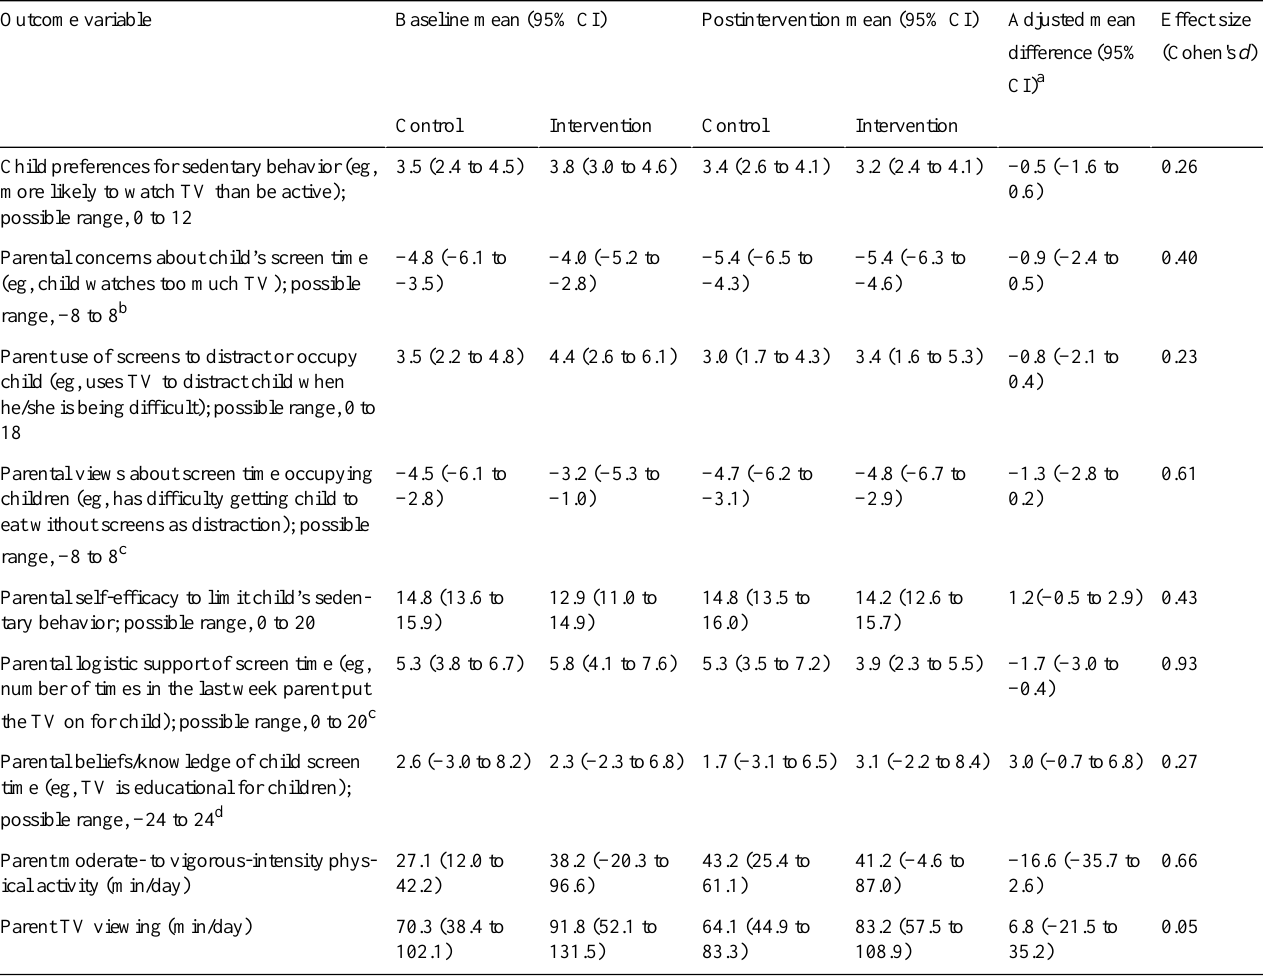
Table 3. Baseline and postintervention values, adjusted differences, and effect sizes for potential